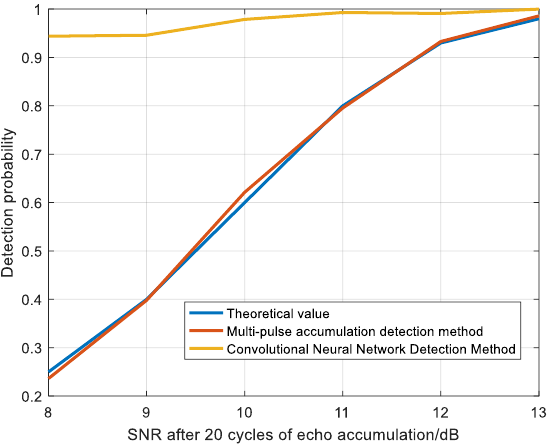
Figure 18. The comparison diagram of the detection probability between the multi-pulse accumula- tion detection method and the method in this paper.